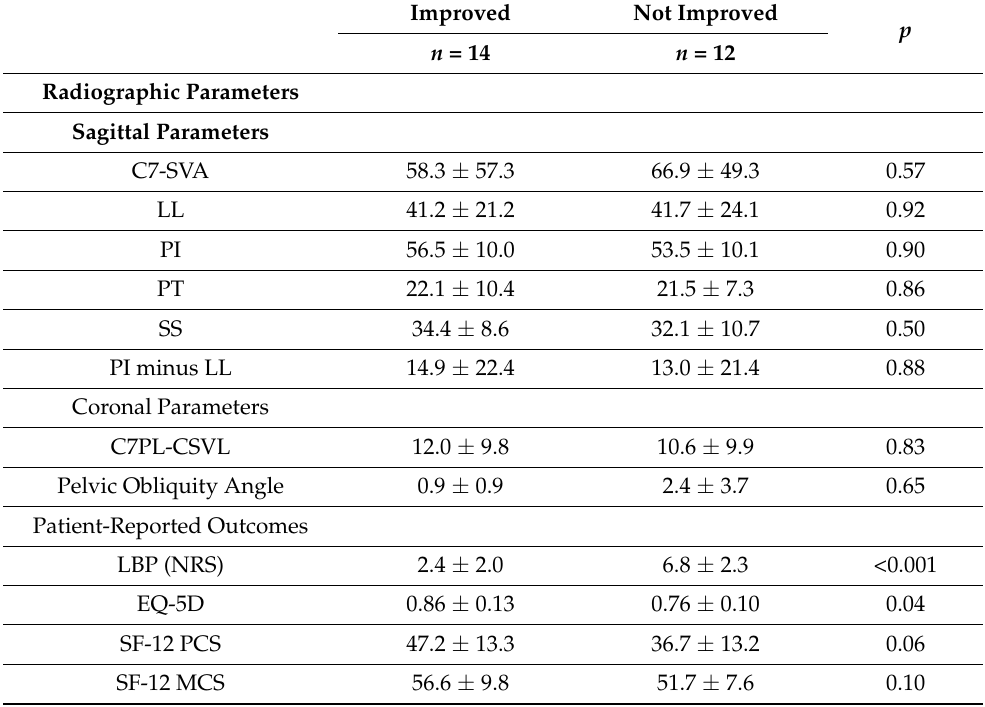
Table 4. Comparison of postoperative radiographic parameters and patient-reported outcomes in patients with preoperative lower back pain (improved vs not